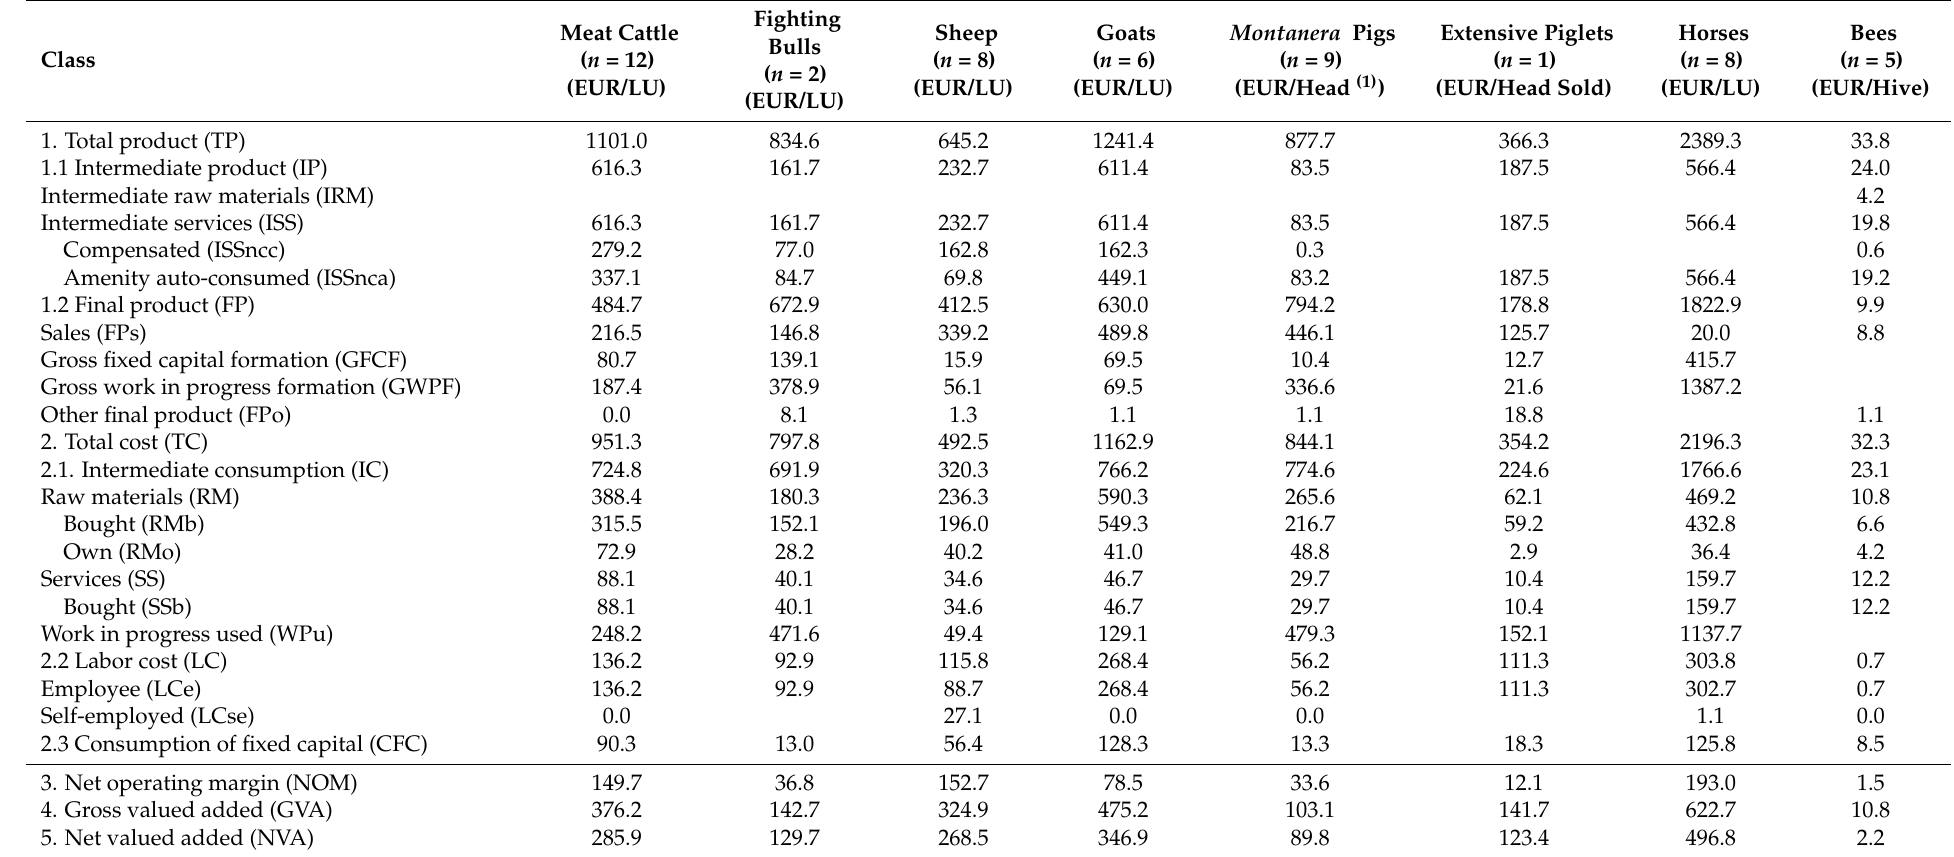
Table A3. Livestock species production account under the AAS for large privately owned dehesas in Andalusia (2010: